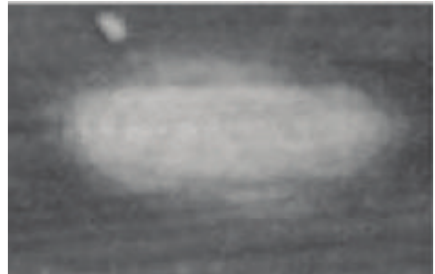
Figure 3: Gray maize leaf disease image.